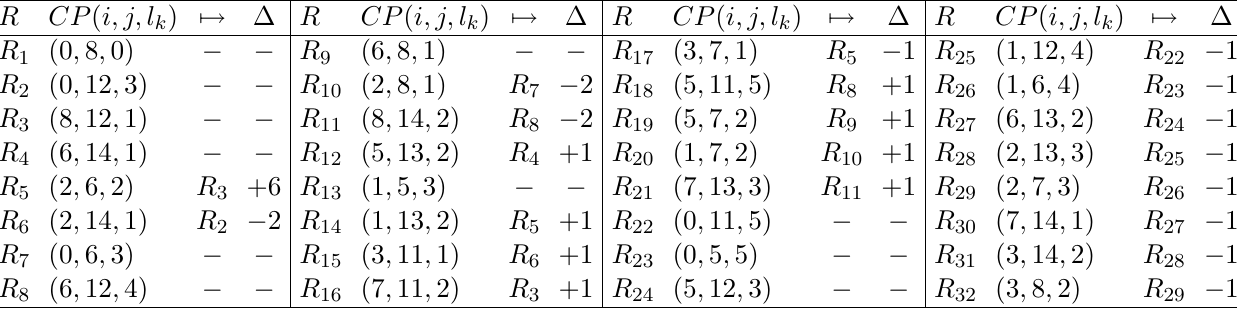
7! R indicates that conflict q p